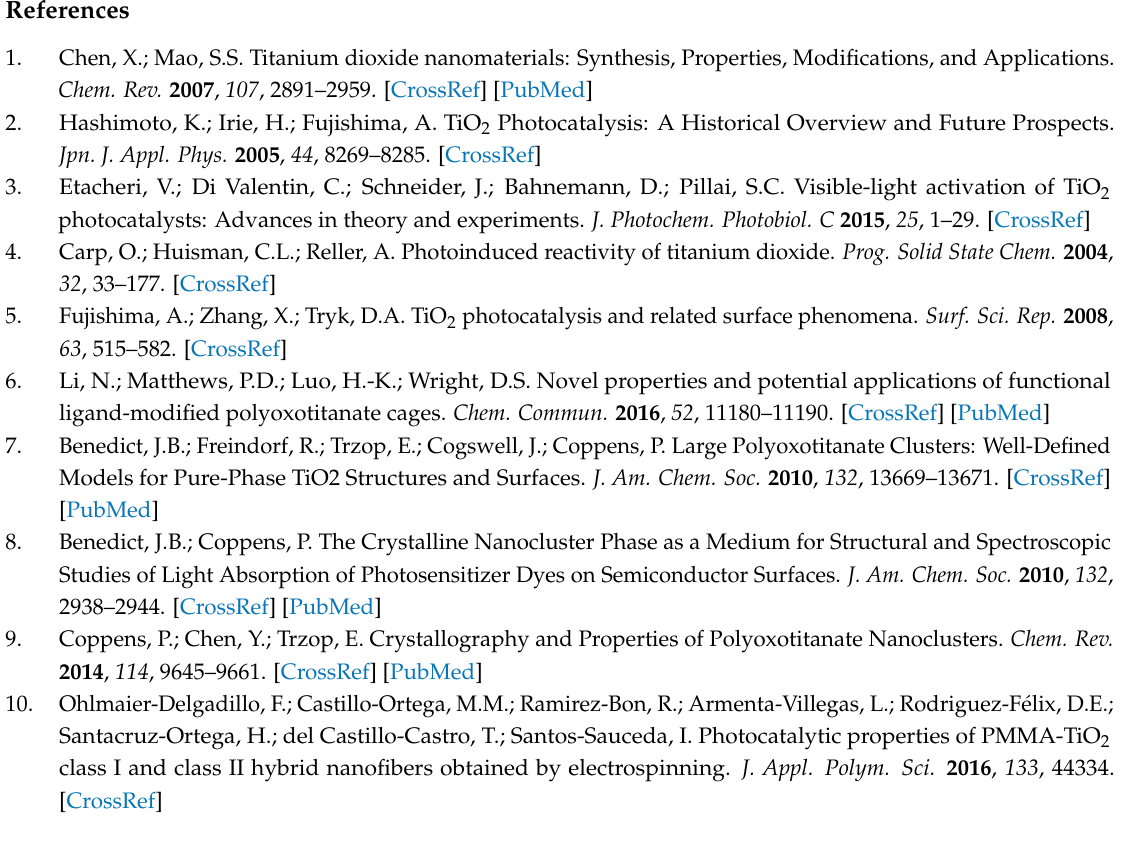
s1, Figure S1: Infrared and Raman spectra of ( 1 )–( 3 ) complexes, Figure S2: The calculated partial density of states of oxo-complexes ( 1 ), ( 2 ), and ( 3 ), Figure S3: DFT calculated HOMO (top) and LUMO (bottom) molecular orbitals of ( 1 ), ( 2 ) and ( 3 ), Table S1: Comparison of the experimental and the calculated (DFT) structural data of {Ti 4 O 2 } cores of studied oxo-clusters: [Ti 4 O 2 (O i Bu) 10 (O 2 CC 13 H 9 ) 2 ] ( 1 ), [Ti 4 O 2 (O i Bu) 10 (O 2 CC 6 H 4 Cl) 2 ] ( 2 ), [Ti 4 O 2 (O i Bu) 10 (O 2 CC 6 H 4 NO 2 ) 2 ] ( 3 ), [Ti 4 O 2 (OMe) 10 (O 2 CC 13 H 9 ) 2 ] DFT( 1 ), [Ti 4 O 2 (OMe) 10 (O 2 CC 6 H 4 Cl) 2 ] DFT( 2 ),